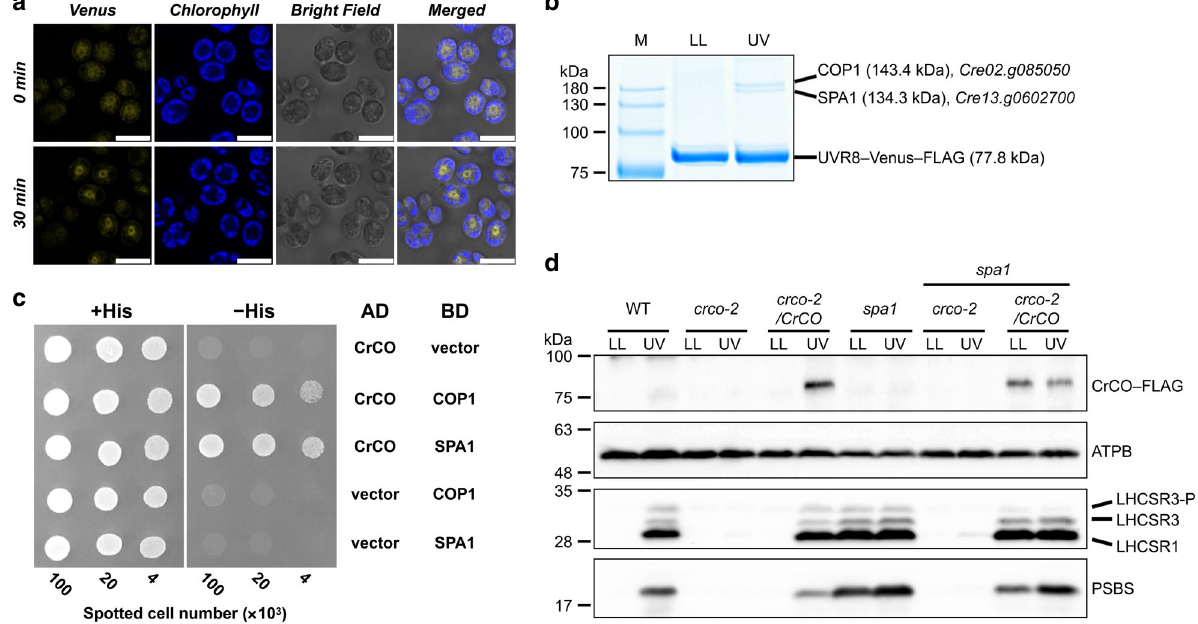
Fig. 3 UVR8 interacts with COP1 and SPA1 to activate the CrCO-based transcriptional complex under UV irradiation. a Confocal images of UVR8 – Venus – 3xFLAG proteins in the DSR1 – comp15 ( uvr8 / UVR8 ) strain. The cells were treated with UV for 30 min. Scale bars, 10 µ m. b After 1 h of UV treatment, the cells were harvested and UVR8 – Venus – 3xFLAG proteins were immunoprecipitated by FLAG (M2) antibody with SURE-beads. The coimmunoprecipitated proteins were identi fi ed by LC-MS/MS analysis of the Coomassie Brilliant Blue-stained polypeptide bands obtained via SDS-PAGE separation after in-gel trypsin digestion. M, molecular mass standard. c Interaction pro fi les among COP1, SPA1, and CrCO visualized with Y2H assays, which were performed using COP1, SPA1, and CrCO fused with the AD and/or BD domains of GAL4. The culture conditions were as described for Fig. 2b. d Immunoblot analysis of LHCSRs, PSBS, and 3xFLAG-fused CrCO to visualize protein accumulation in the wild-type control (WT), crco-2 , crco-2 / CrCO , spa1 , spa1 crco-2 , and spa1 crco-2 / CrCO strains before and after UV treatment. ATPB proteins were included as the loading